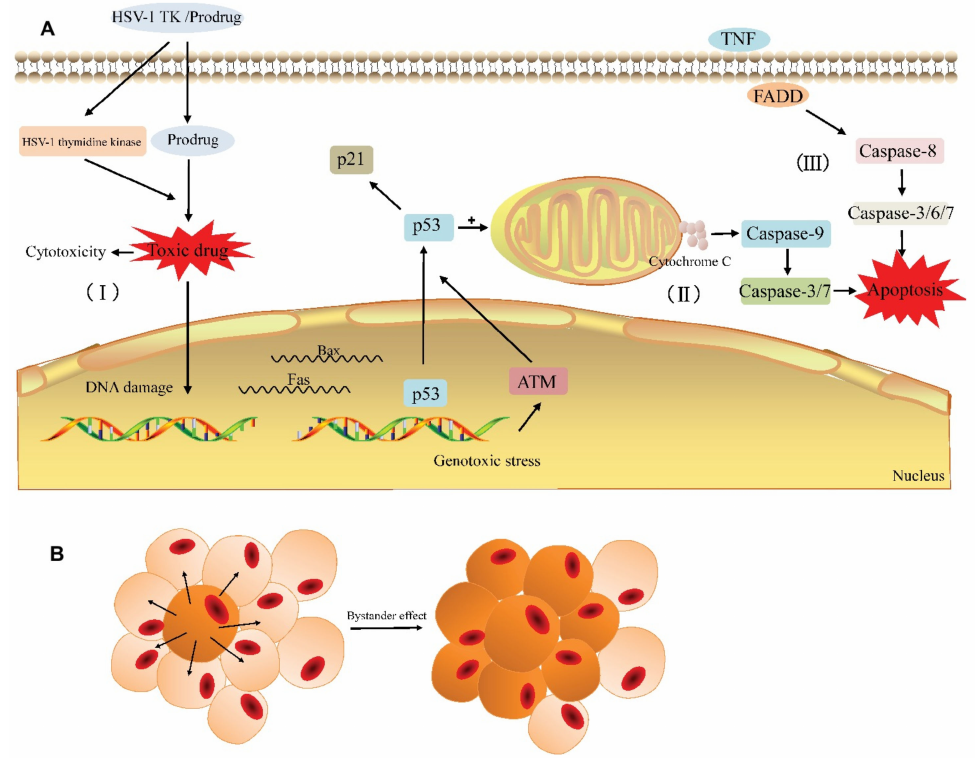
Figure 4. General principle of the HSV-TK suicide gene system. ( A ) The HSV-TK/prodrug-system- induced cytotoxicity and apoptosis in tumor cell. (I) The HSV-1 TK gene coding for thymidine kinase is delivered to the target cell. The expression of HSV-1 thymidine kinase and cellular kinases allows a prodrug (GCV) to be activated as the toxic drug (GCV-TP) in the cell and damage the DNA of the target cell. (II) Gene therapy induces endogenous apoptosis by activating p53 signaling pathway in the target cell. (III) Gene therapy induces exogenous apoptosis. ( B ) The bystander effect induces the death of adjacent cells. With the permission of